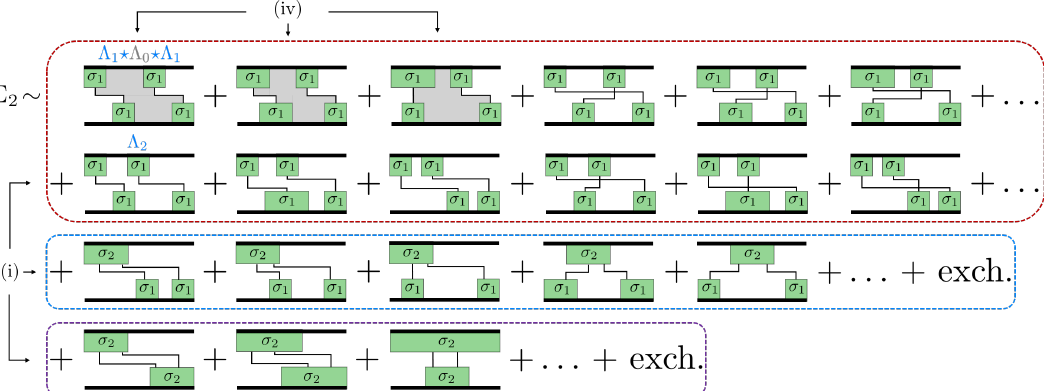
Figure 13: Contributions to Σ based on the diagrammatic rules (i)-(v) in Sec. 4.3. 2 [ k † ] on the upper (lower) The bold lines indicate a renormalized propagation k 0 0 branch. Each diagram represents a definite two-branch time-ordering, i.e. the time- [ τ τ (cid:48) ] on the upper [ lower ] branch integrations over the internal times τ + , τ (cid:48) − , + − are restricted as to not overtake each other. The colored boxes group the different distributions of the external vertices over generators σ µ by rule (i). The first three diagrams are build up from reducible diagrams which are forced to be irreducible by inserting fragments Λ (gray) by rule 0